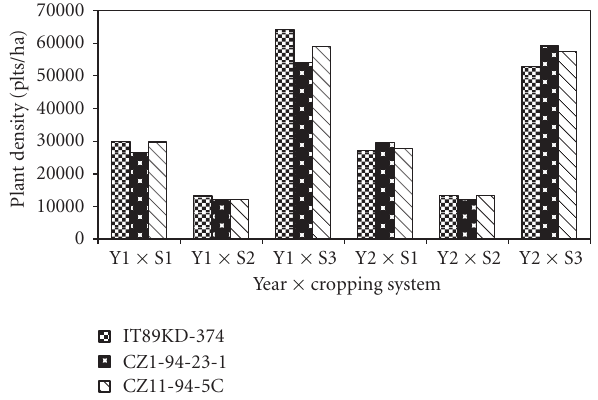
Figure 3: Cowpea plants density (plants/ha) as a ff ected by year × cropping system × cowpea variety interactions e ff ects ( P < 0 . 01) at harvest at Cinzana Agronomic Research Station, 2007 and 2008. Y1: year 1 (2007); Y2: year 2 (2008), S1: Alternate rows intercropping (1 row millet/1 row cowpea), S2: Inter hills inter cropping (2 hills millet/1 hill cowpea), S3: Cowpea sole crop, Cowpea